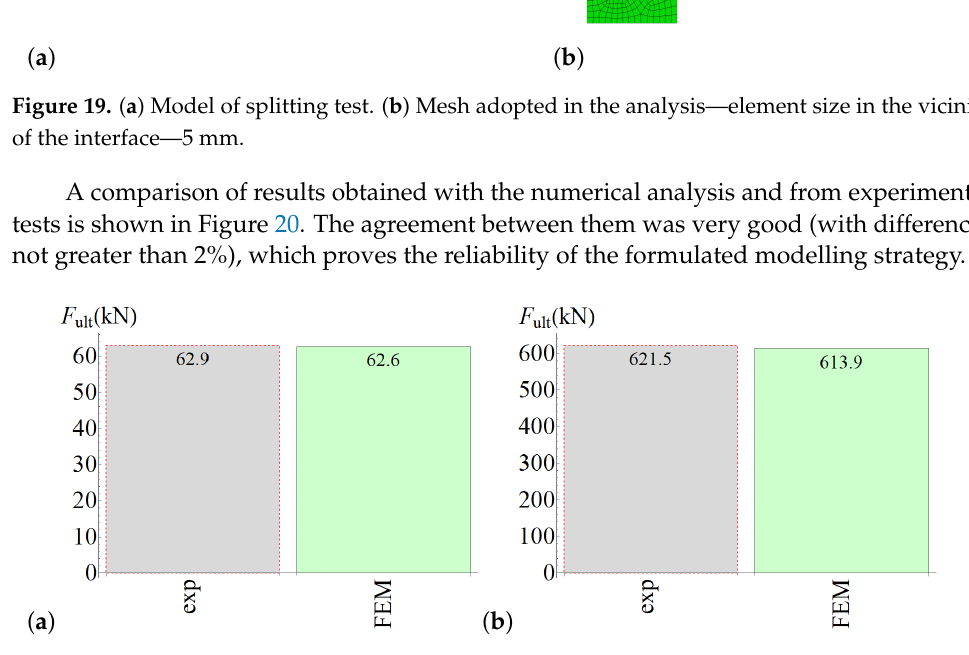
Figure 20. ( a ) Results of the splitting test simulation. ( b ) Results of the slant-shear test simulation.